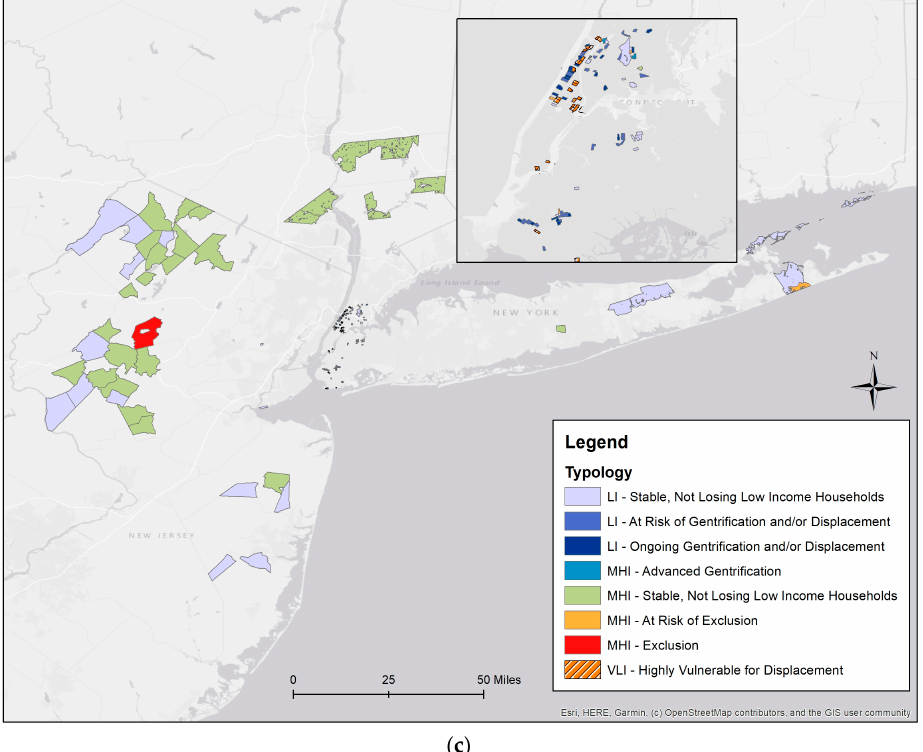
Figure 1. Results of income categories, gentrification subcategories, and gentrification subcategories located in Transit Deserts (( a ) census tracts by income categories; ( b ) census tracts by gentrification progress; ( c ) census tracts defined as transit deserts by gentrification progress). Table 4. Results of logit models by